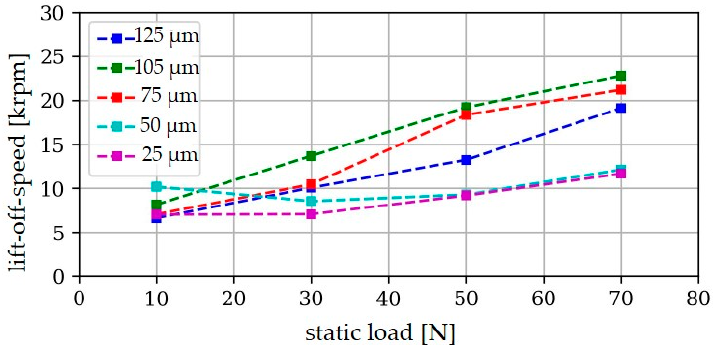
Figure 7. Illustration of the determined lift-off speeds (krpm) depending on the applied static load (N) for the bearing configurations with the nominal clearances; (blue: 125 µm), (green: 105 µm), (red: 75 µm), (turquoise: 50 µm), and (purple: 25 µm); (1 krpm = (100/3)π ⋅ rad/s).